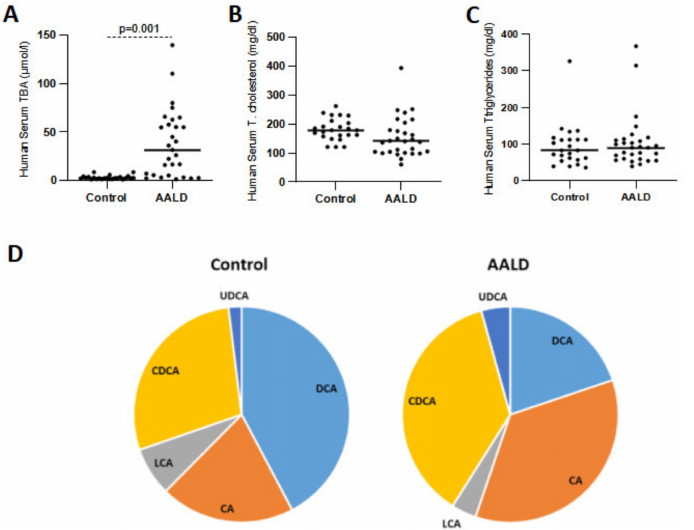
Figure 10. Serum total bile acid ( A ), cholesterol ( B ), and triglyceride ( C ) concentrations in humans. Individual bile acids were identified by GC-MS-SIM (men, n = 3 per groups) and are shown as the percentage of total bile acid pool ( D ). AALD, alcohol-associated liver disease, CA, cholic acid; CDCA, chenodeoxycholic acid; Cont, control diet; DCA, deoxycholic acid; LCA, lithocholic acid; UDCA, ursodeoxycholic